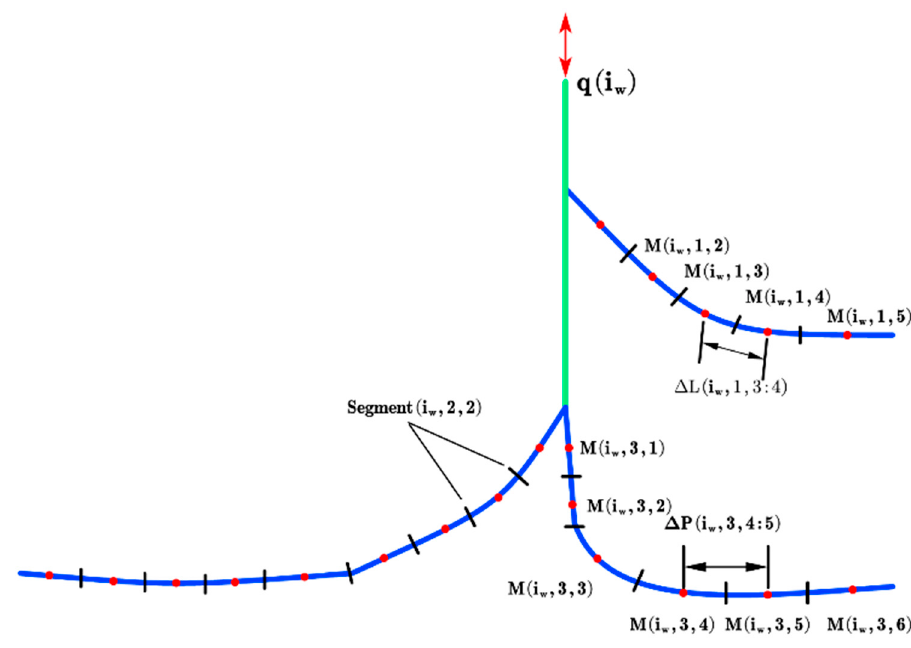
Figure 2. Schematic diagram of wellbore segmentation in semi-analytical model.